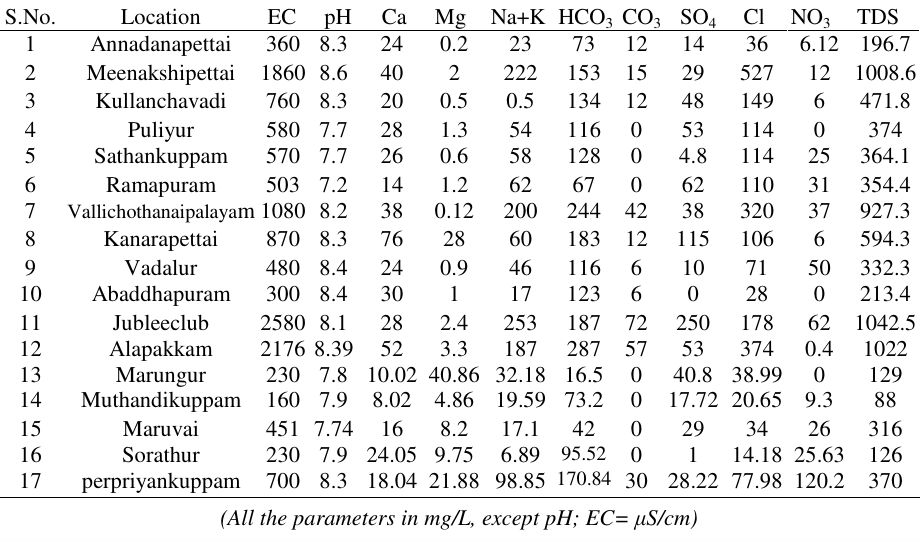
Table 1. Hydrogeochemical data (Post monsoon of 2007)